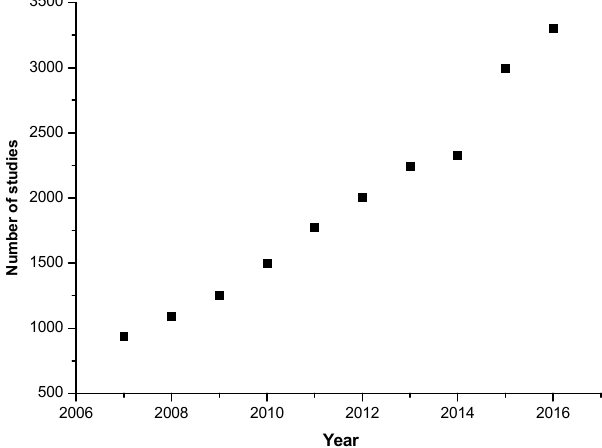
Figure 1. Growth in the number of food and antioxidant studies, from 2007 to 2016.